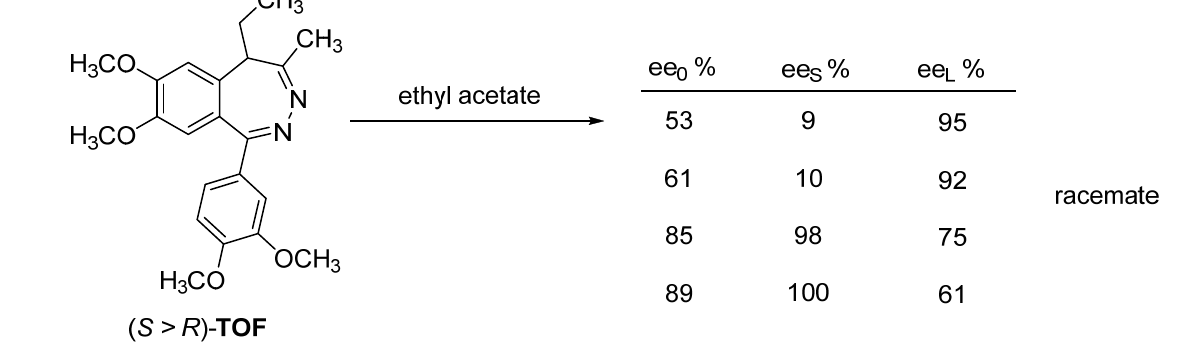
Figure 22. Recrystallization of racemate-forming tofisopam.